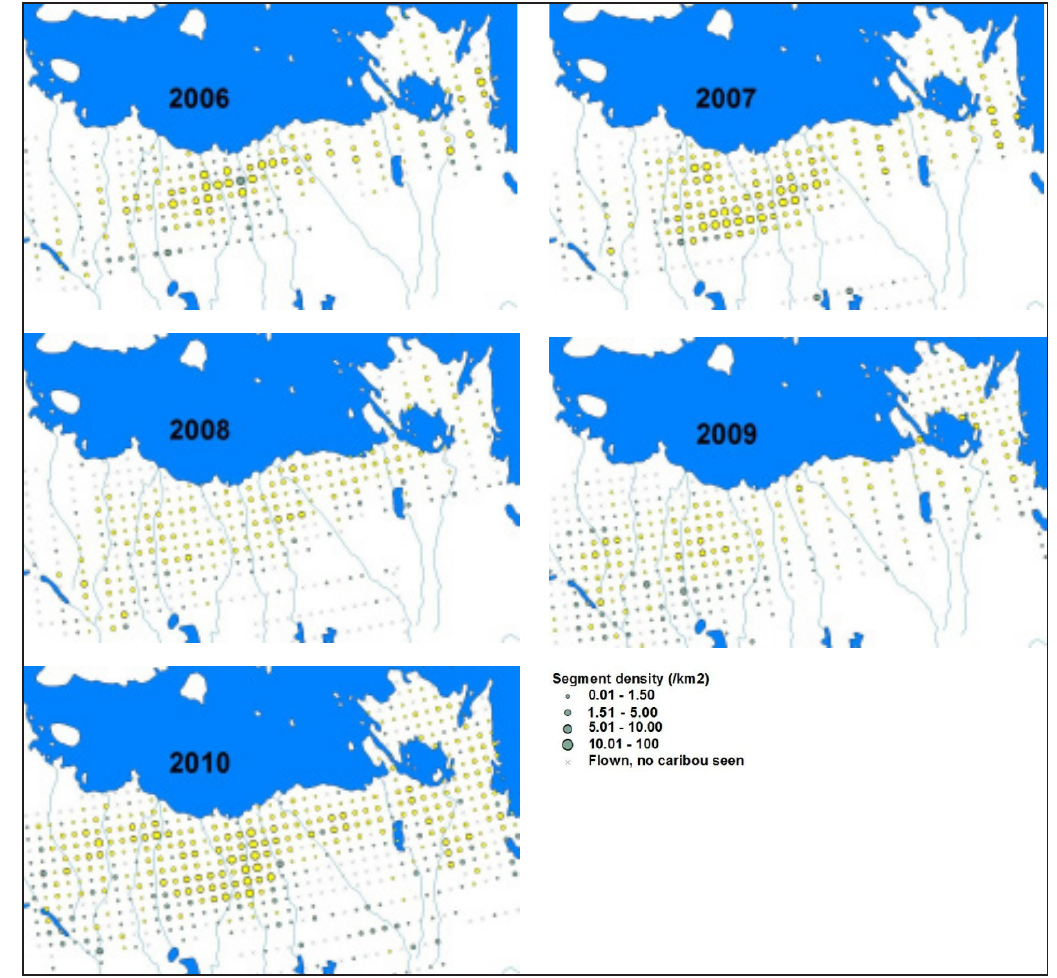
Fig. 8. Density of caribou observed by 10-km segment, Ahiak calving ground distribution surveys, 2006-10. Yellow circles denote density of 1+-year-old caribou where breeding females were present within a segment, regardless of the proportion of non-breeders. Grey circles are density of non-breeders where no breeders present within that segment. Crosses are segments flown but no caribou observed. Scale and graduated symbols constant among